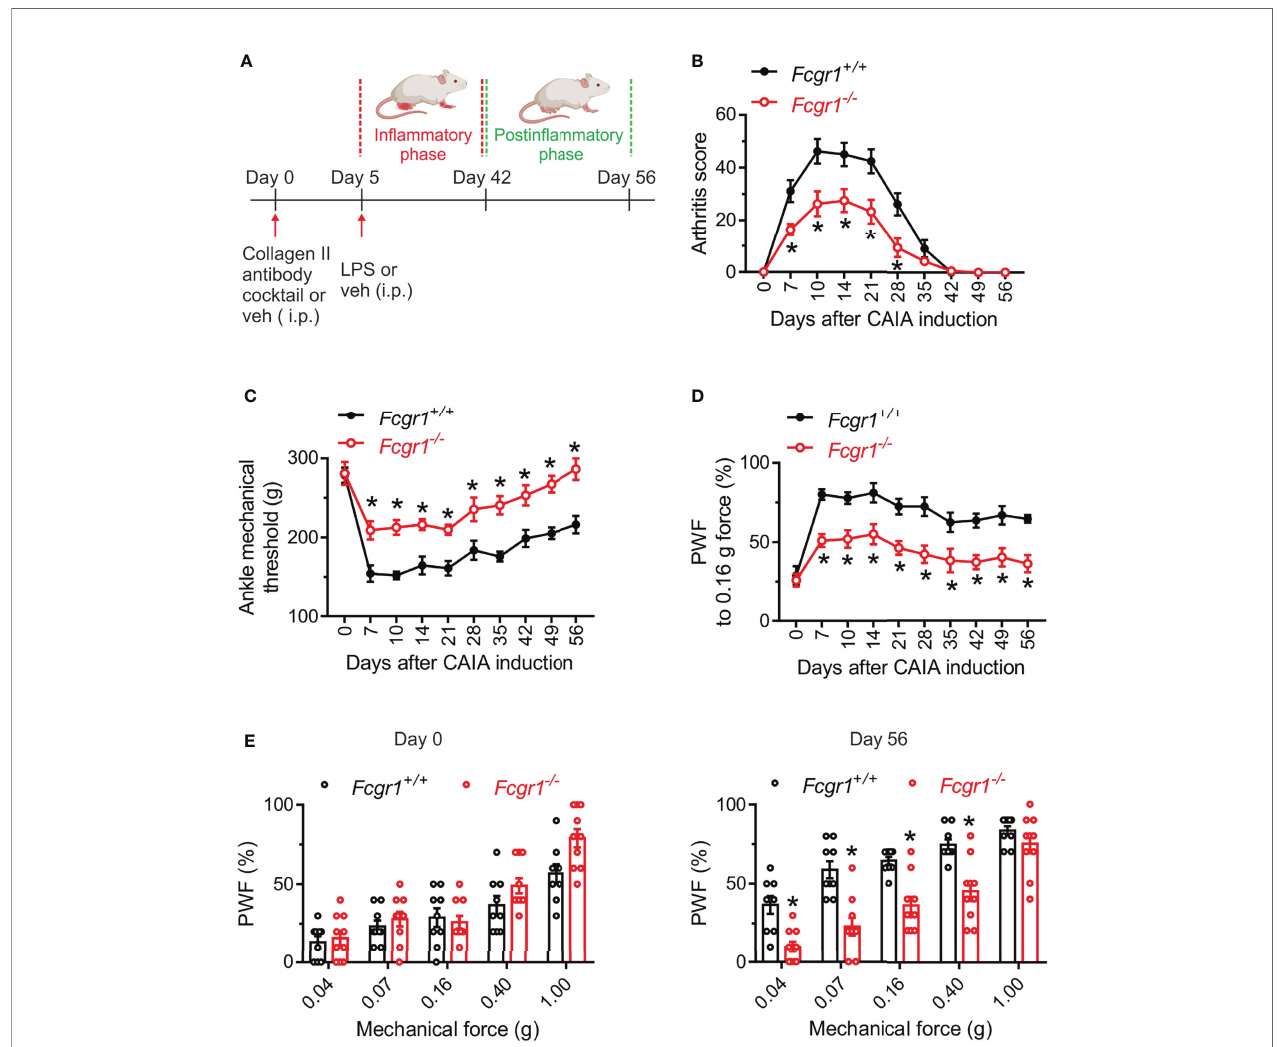
FIGURE 1 | Global deletion of Fcgr1 attenuates arthritis pain and joint swelling in female mice in the CAIA model. (A) Experimental diagram showing the induction of CAIA in female mice on a BALB/c background. (B – D) Time course of arthritis score (B) , mechanical threshold in the ankle (C) , and paw withdrawal frequency (PWF) in response to 0.16 g force in the hind paw (D) , in wildtype ( Fcgr1 +/+ ; n = 9 mice) and global Fcgr1 -/- (n = 10 mice) mice with CAIA. *p < 0.05, versus Fcgr1 +/+ ; two- way repeated measures ANOVA followed by Bonferroni correction. (E) Comparison of PWF in response to a series of mechanical forces (0.04, 0.07, 0.16, 0.40 and 1.0 g) in the hind paw of mice on days 0 and 56 after CAIA induction between Fcgr1 +/+ (n = 9) and Fcgr1 -/- (n = 10) mice. *p < 0.05 versus Fcgr1 +/+ ; two-way repeated measures ANOVA followed by Bonferroni